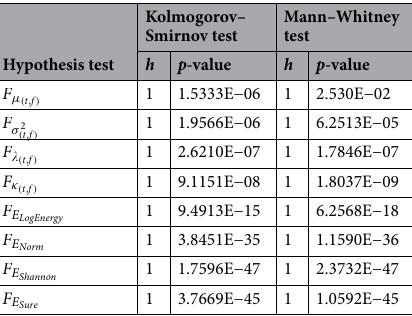
Table 1. Statistical significance of indices of joint moments and entropy measurements.